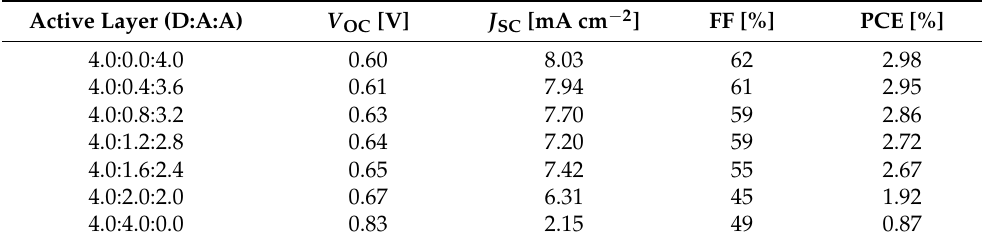
Table 2. Photovoltaic performances of the P3HT: o -DPP-PhCN:PCBM devices fabricated with